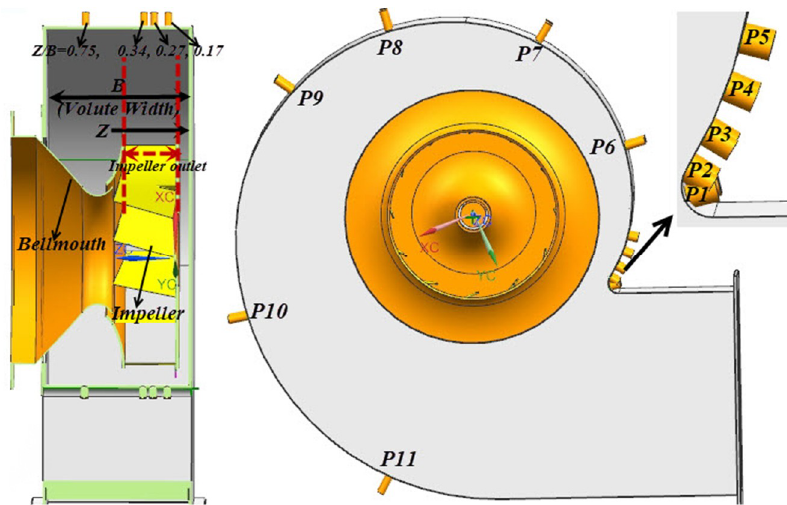
Figure 6. Sketches of the fan with the measurement points. Table 2. Angular coordinate of the measurement points over the volute.